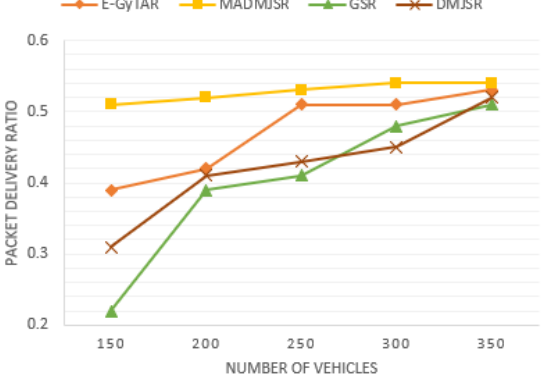
Figure 5. Packet delivery ratio on an increasing number of vehicles.